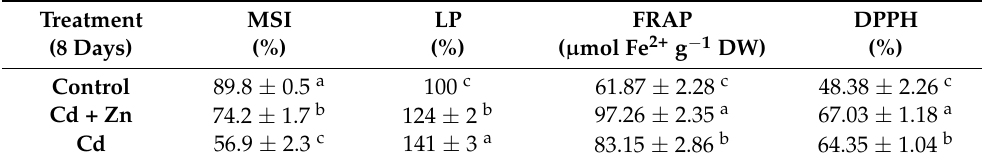
Table 1. Effects of excess (900 µ M) Zn on the Cd-induced changes in the leaf cell membrane sta- bility index (MSI), and the lipid peroxidation (LP) of membranes (% of control) of the clary sage ( Salvia sclarea L.) leaves. Antioxidant capacity of the leaf extracts after exposing the plants to different treatments for 8 days measured by FRAP and DPPH assays.